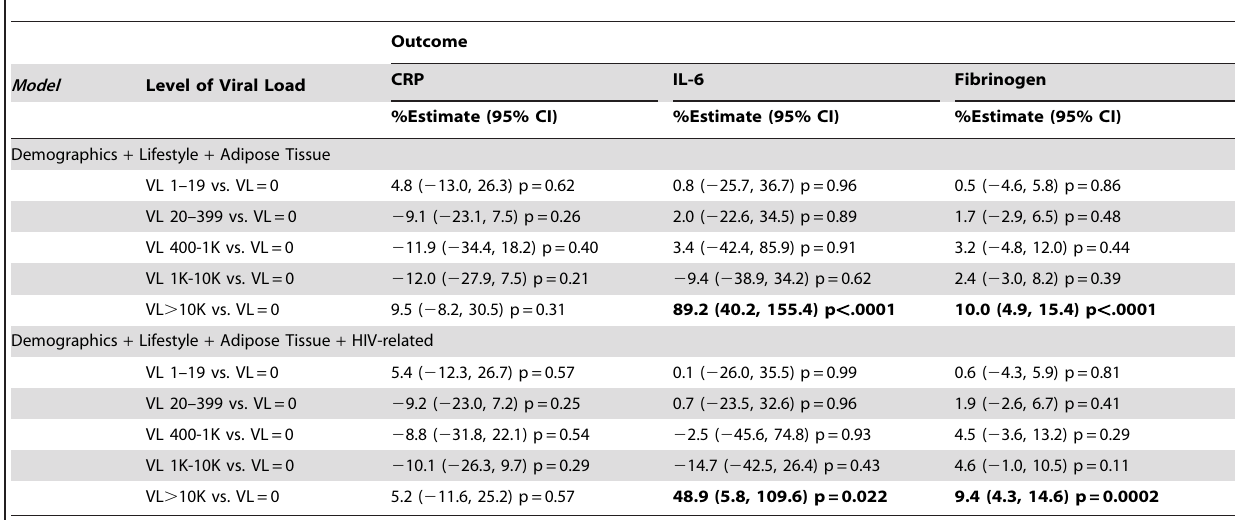
Table 2. Association of discretized HIV RNA levels with CRP, IL-6, and fibrinogen in all HIV-infected